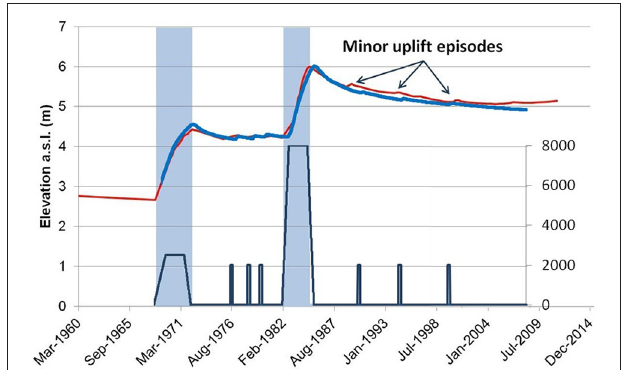
FIGURE 7 | Comparison of the ground uplift (left axis) in the central area of the Campi Flegrei caldera (red line), measured at benchmark n.25 of the leveling network of Osservatorio Vesuviano - INGV (Del Gaudio et al., 2010) and the ground uplift obtained from a simulation (blue line), using the parameters in Table 1 . The dark blue line is the mass flow rate in kg/s (right axis). The two light blue rectangles indicate the two major uplifts.